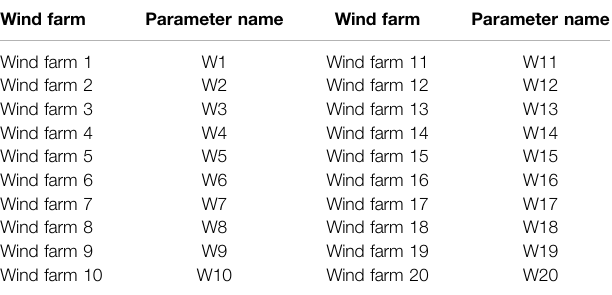
TABLE 2 | Parameter names of wind